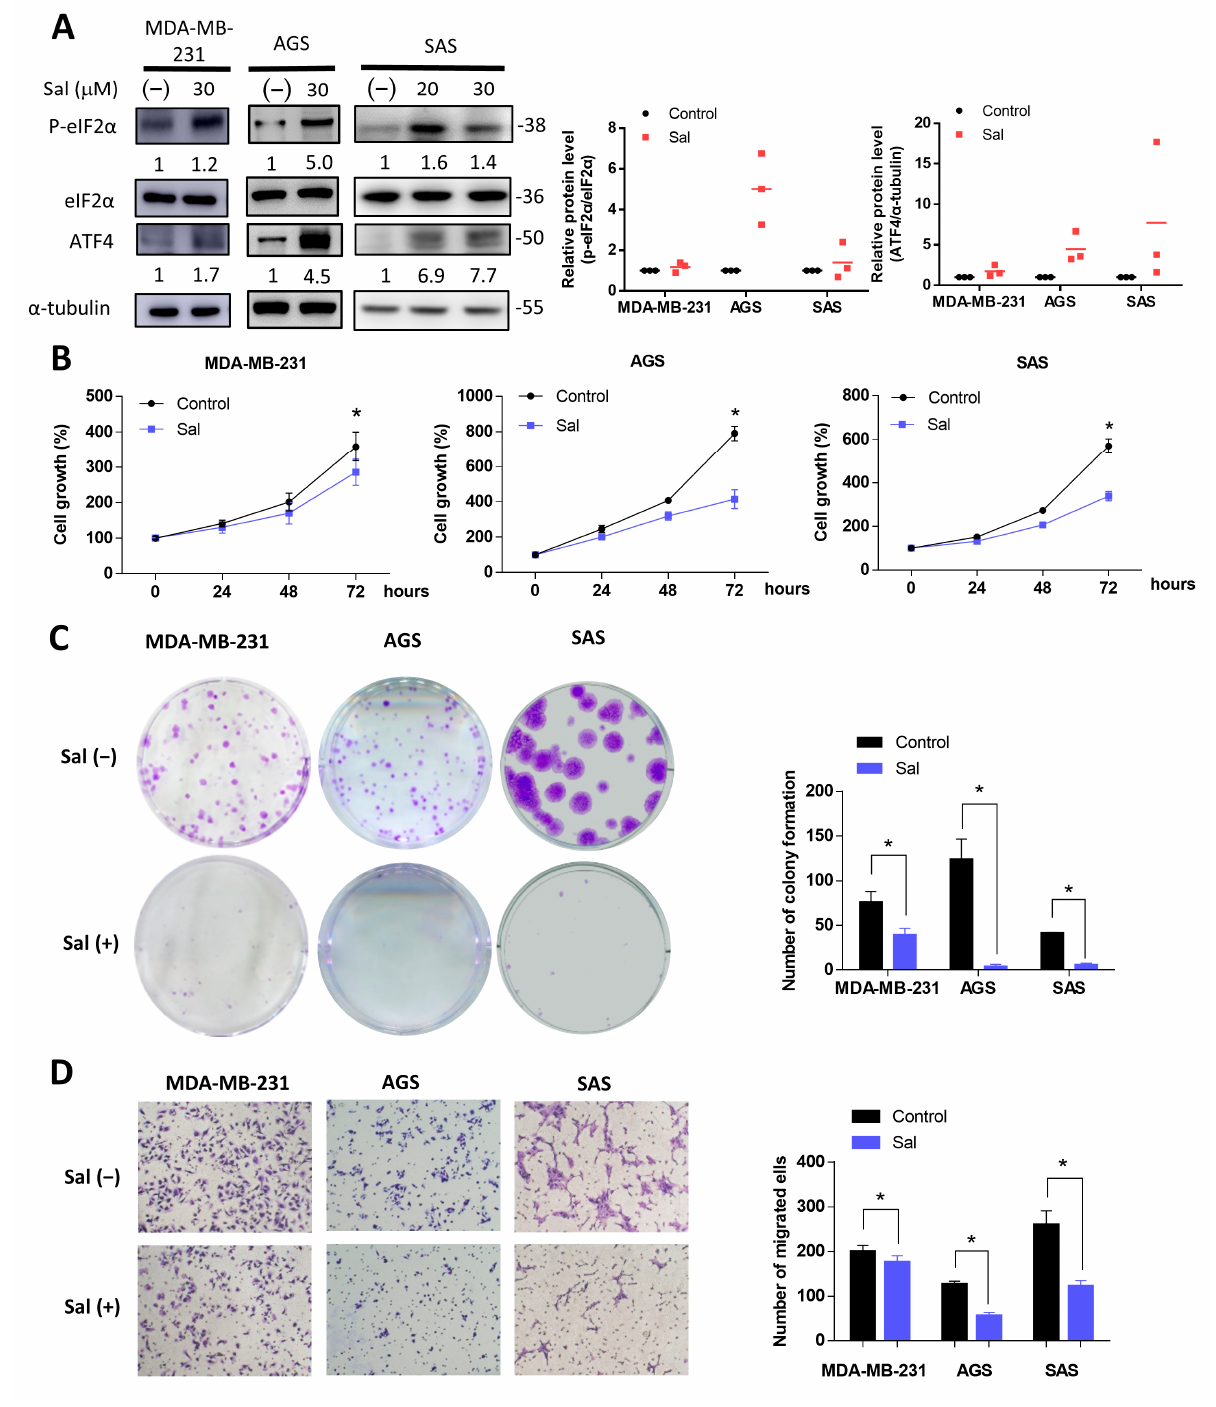
Figure 1. Salubrinal inhibited cell growth and migration in cancer cells. Three cancer cell lines (MDA-MB-231, AGS, and SAS) were treated with or without 30 µ M of salubrinal in normal culture medium. ( A ) The protein levels of eIF2 α , p-eIF2 α , and ATF4 were detected using Western blotting after salubrinal treatment for 24 h; The value of the control group was set as 1. ( B ) The cell growth rate at 0, 24, 48, and 72 h after salubrinal treatment was detected by a sulforhodamine B (SRB) assay. ( C ) The colony formation ability was checked after treatment with or without salubrinal for 10 days in MDA-MB-231 cells, for 7 days in AGS cells, and for 9 days in SAS cells. ( D ) The ability of cell migration was detected using a transwell migration assay. After salubrinal pre-treatment for 24 h, the migration time was found to be 6 h for MDA-MB-231 cells, 8 h for AGS cells, and 24 h for SAS cells. The photograph was taken by a microscope (100 × magnification). The data are presented as the means ± SEMs of the results from three independent experiments. * p < 0.05. Sal: